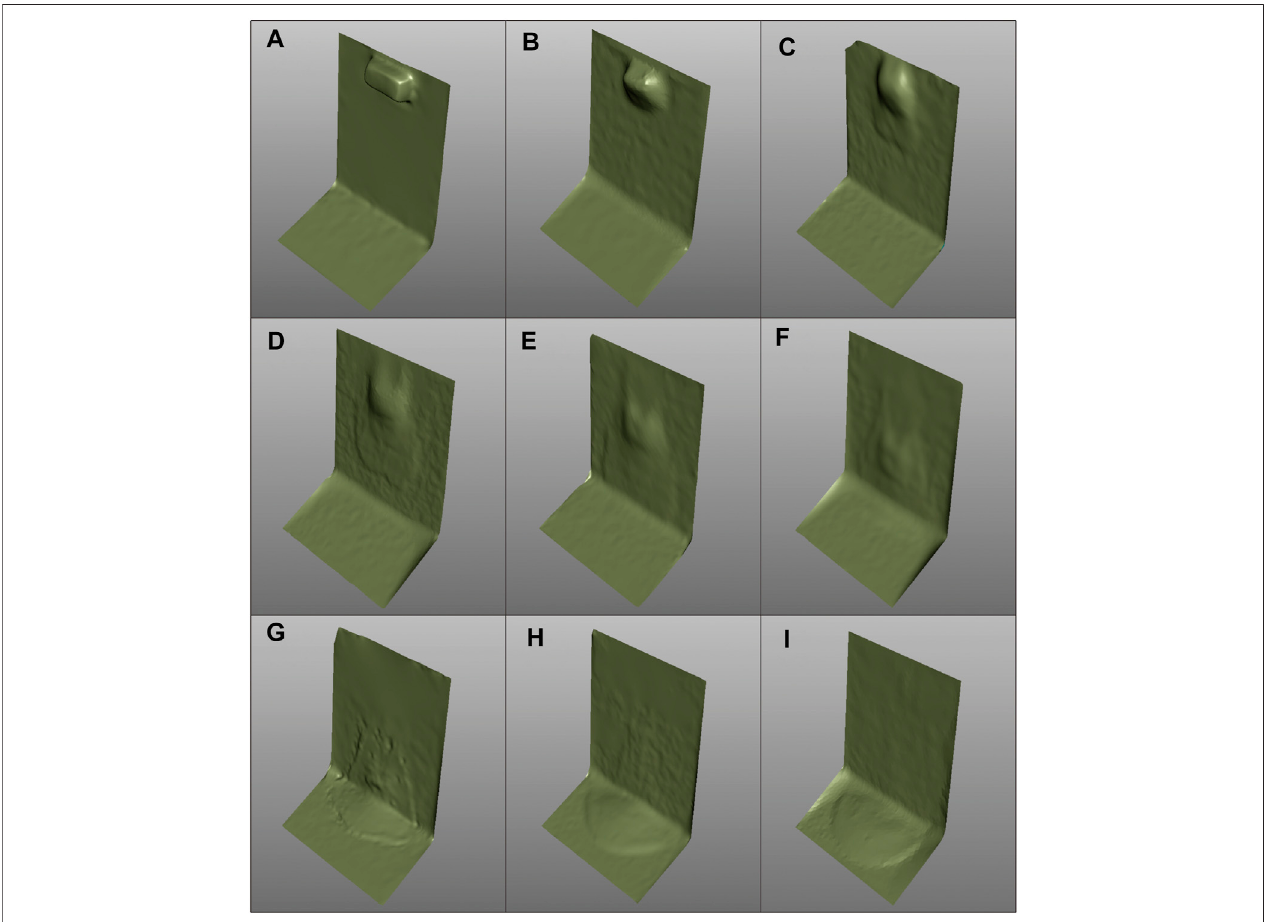
FIGURE 3 | Sliding process